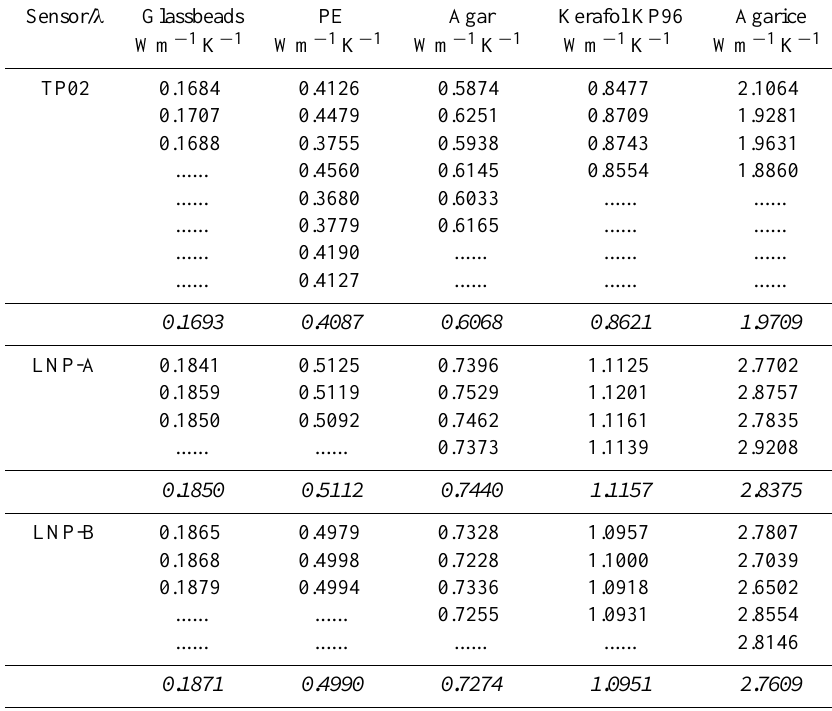
Table 1. Thermal conductivity measurement results for the different calibration materials and sensors.